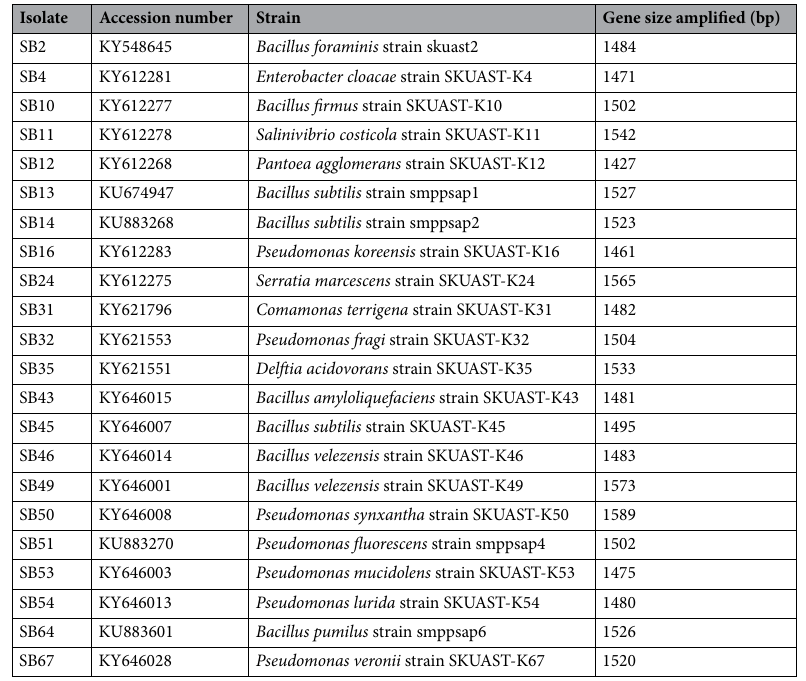
Table 2. Bacterial strains as identified on 16S rRNA gene sequencing.